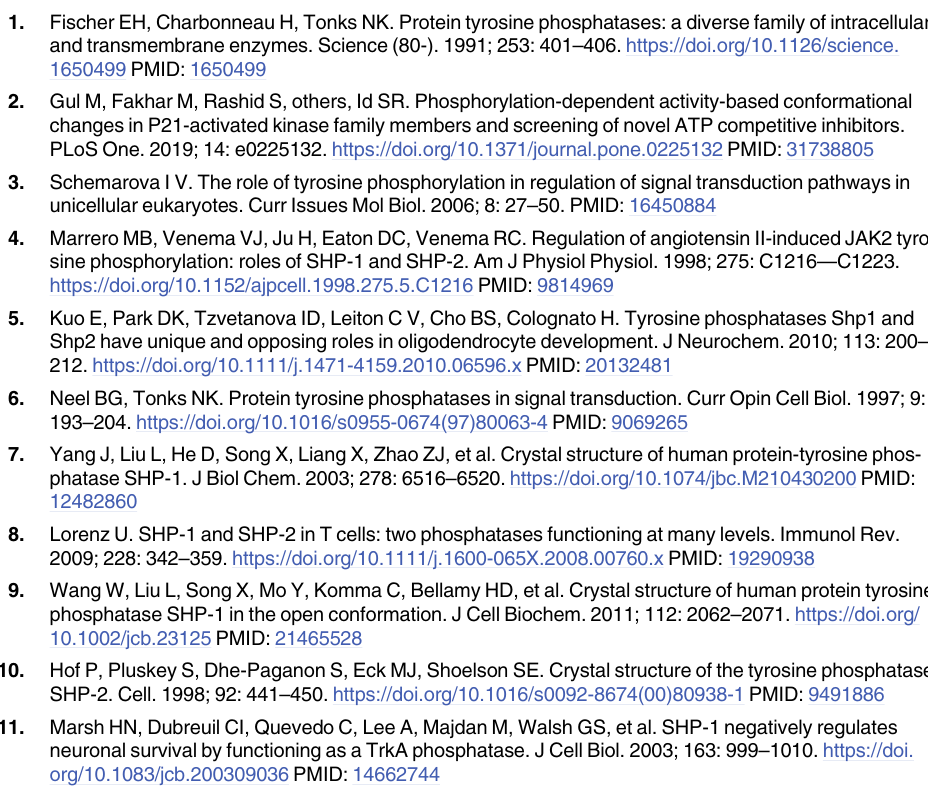
S8 Fig. Dynamic correlation heatmap plots to estimate positive and negative correlated motions. (A) SHP-1, (B) c-Src open , (C) c-Src close , (D) c-Src open - SHP-1, and (E) c-Src close